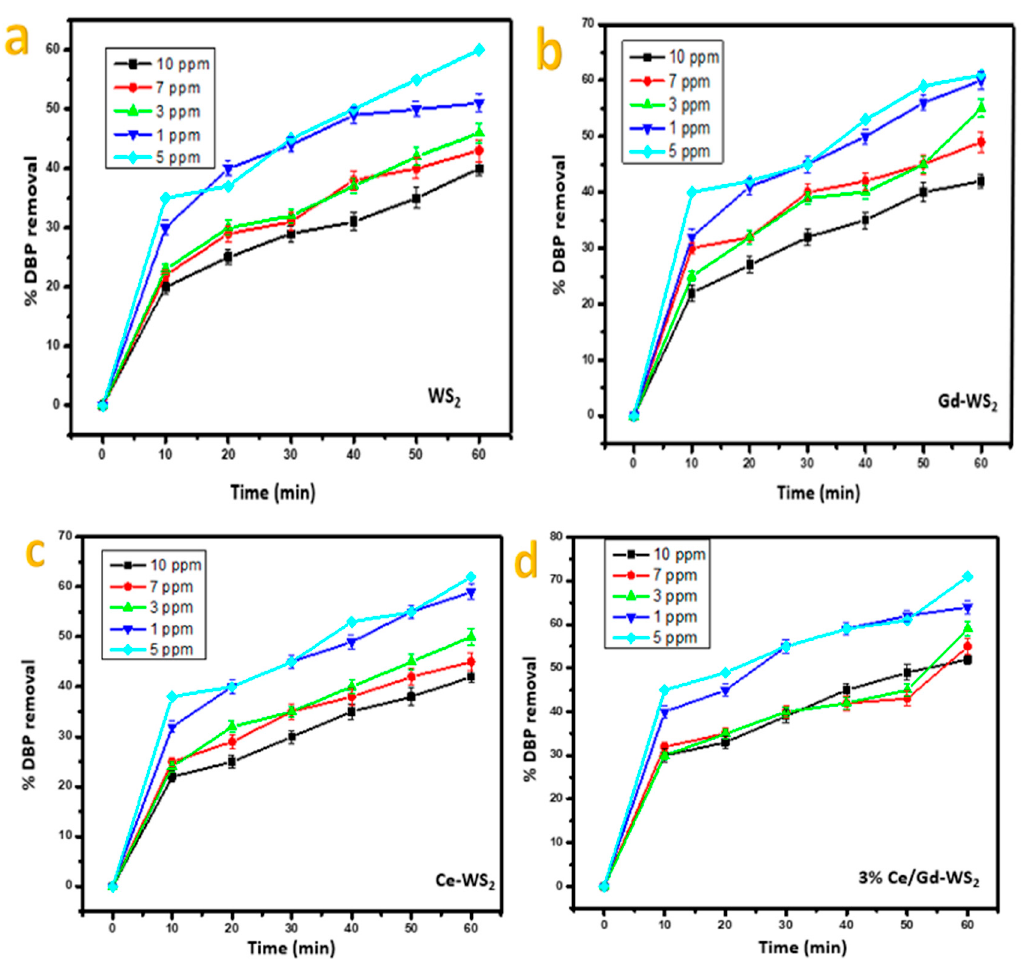
Figure 3. The influence of initial concentration on the degradation of DBP with ( a ) pristine WS 2 , ( b ) Gd-WS 2 , ( c ) Ce-WS 2 , and ( d ) 3% Ce/Gd-WS 2 . ( b ) Gd-WS 2 , ( c ) Ce-WS 2 , and ( d ) 3% Ce/Gd-WS 2